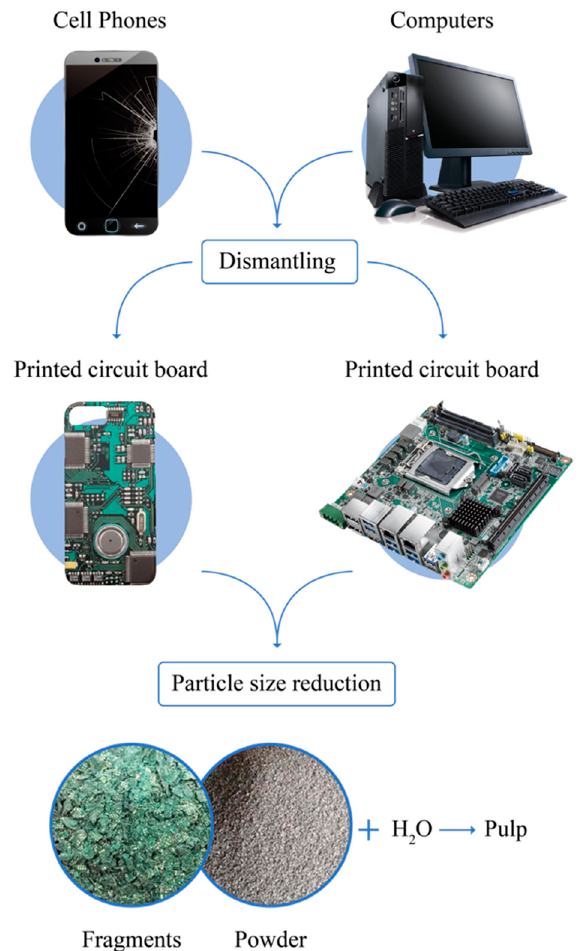
Figure 2. Pre ‐ treatment to obtain the PCBs. Figure 2. Pre-treatment to obtain the